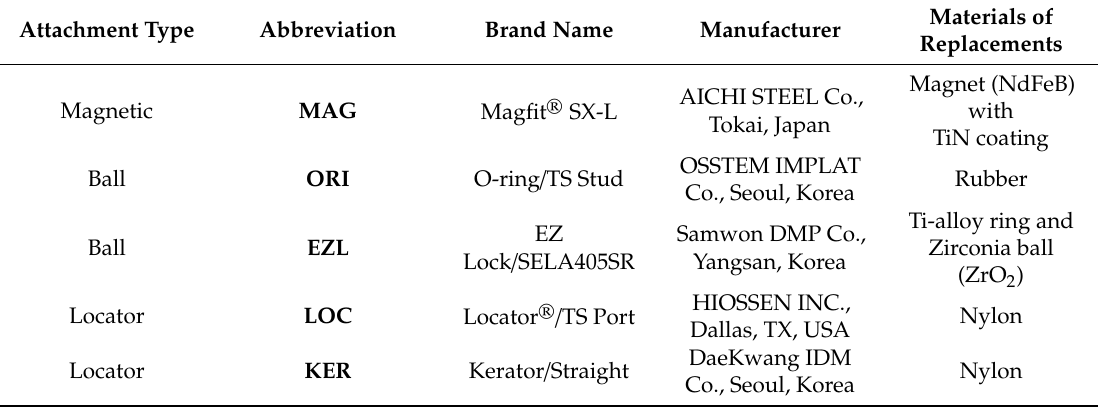
Table 1. The attachment systems investigated in this